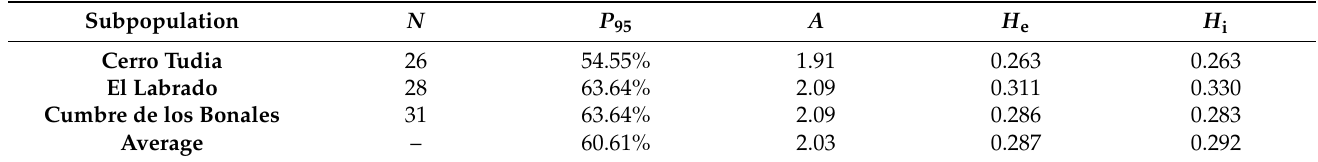
Table 1. Levels of genetic diversity of the three studied subpopulations of Centaurea tentudaica . N , sample size; P 95 , percentage of polymorphic loci (0.95 criterion); A , mean number of alleles per locus; H e , unbiased expected heterozygosity; H i , individual heterozygosity. Subpopulation N P 95 A H e H i Cerro Tudia